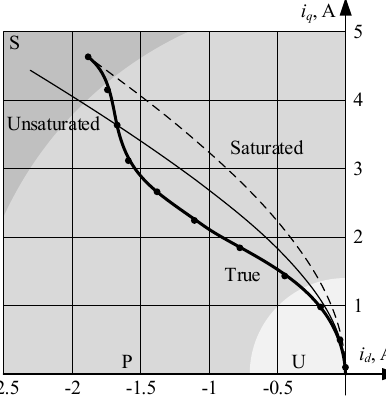
Figure 7. Test motor MTPA trajectories in i d i q plane.